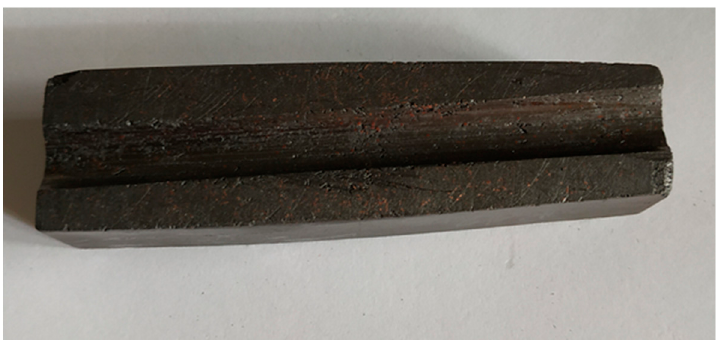
Figure 3. An exemplary ready-made brush.